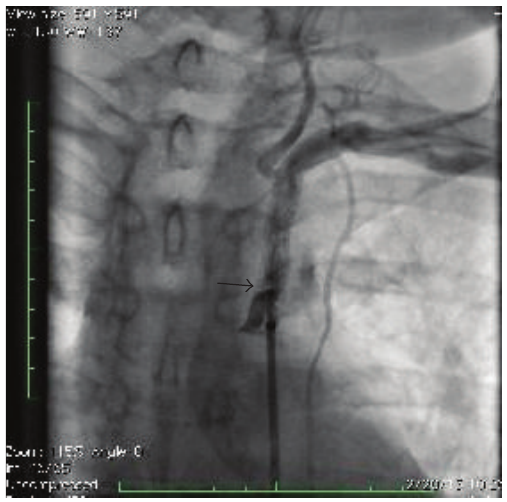
Figure 6: Angiogram showing mobile fractured in-stent stenosis in diastole.